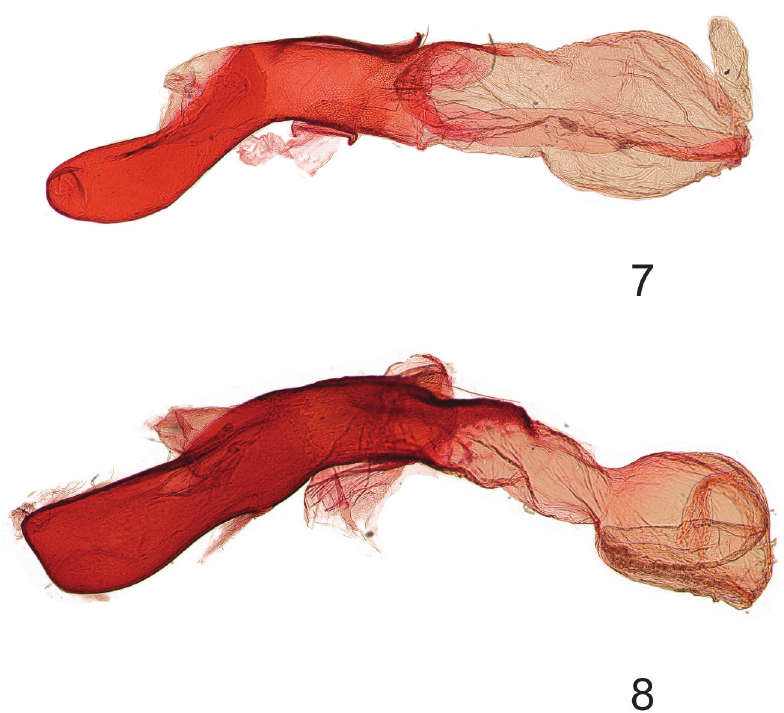
Figures 7–8. Aedeagi of Gadirtha species. 7 Gadirtha fusca sp. n. 8 Gadirtha impingens